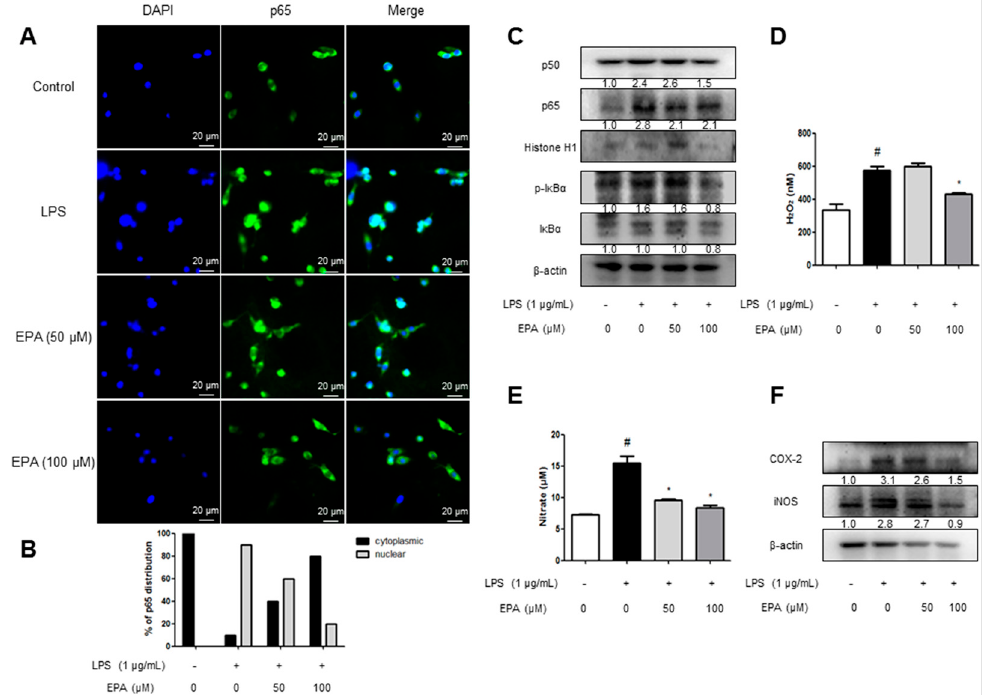
Figure 5. Inhibitory effect of Krill oil on neuroinflammatory responses in microglia cells. To find the effect of anti-oxidative stress, microglial BV-2 cells were treated with 1 µg/mL of LPS and 50, 100 µM of EPA. The cultured microglial BV-2 cells were incubated with anti-p65 (green) and DAPI staining (blue) ( A ). Quantification of p65 subcellular distribution in one representative of three independent experiments ( B ). Fluorescence was developed using Alexa 488-conjugated anti-mouse secondary antibodies. Phosphorylation of I κ B, and p50 and p65 translocation were detected by Western blotting using specific antibodies in microglial BV-2 cells. β -actin and Histone H1 protein were used as an internal control ( C ). Hydrogen peroxide level was assessed using a specific detection kit, as described in Methods ( D ) ( n = 5). NO level was measured in EPA treated microglial BV-2 cells ( E ) ( n = 5). COX-2 and iNOS proteins were detected by Western blotting using specific antibodies in EPA treated microglial BV-2 cells ( F ). The graphs under Western blotting are the relative protein expression of bands. Each band